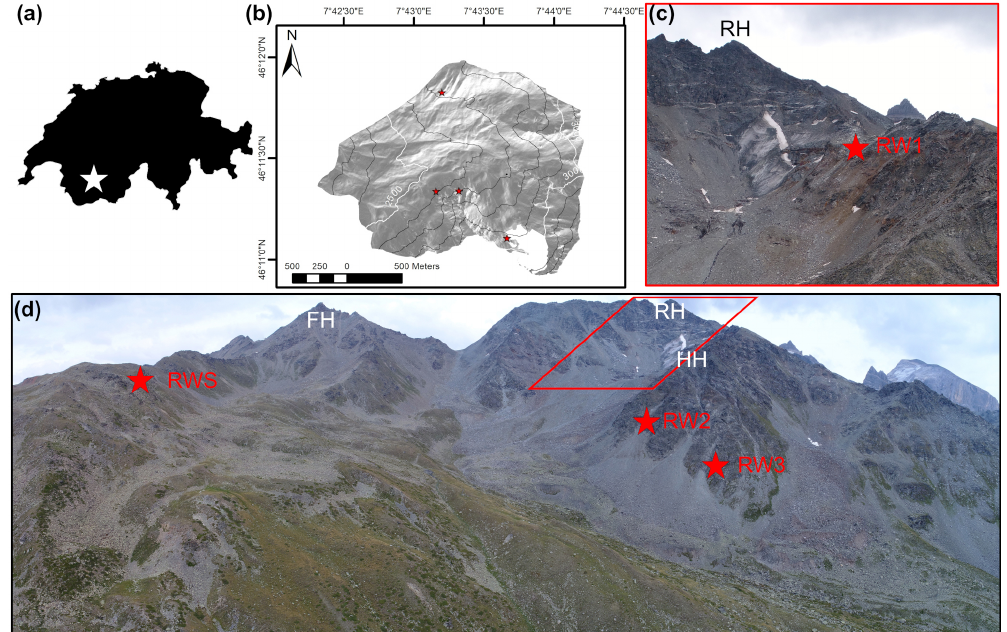
Figure 1. (a) Location of the Hungerli Valley in Switzerland. (b) Hillshade model with highlighted crackmeter locations (red stars; Swiss Alti3D 2m provided by the Federal Office of Topography, swisstopo). (c) Drone photo of the Rothorn cirque with the location of RW1. (d) Drone photo of the Hungerli Valley with locations of RW2, RW3 and RWS. The red parallelogram highlights the photo extent of (c) . Initials show the location of mountain peaks Furggwanghorn (FH, 3161m), Rothorn (RH, 3277m), Hungerlihorli (HH, 3007m) and Brändjispitz (BS, 2852m) in the